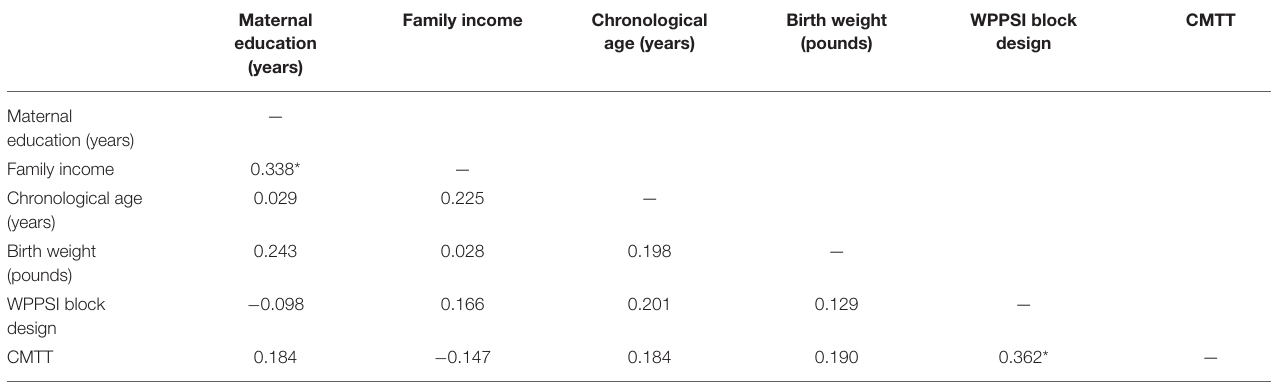
TABLE 2 | Correlations between spatial performance and demographic